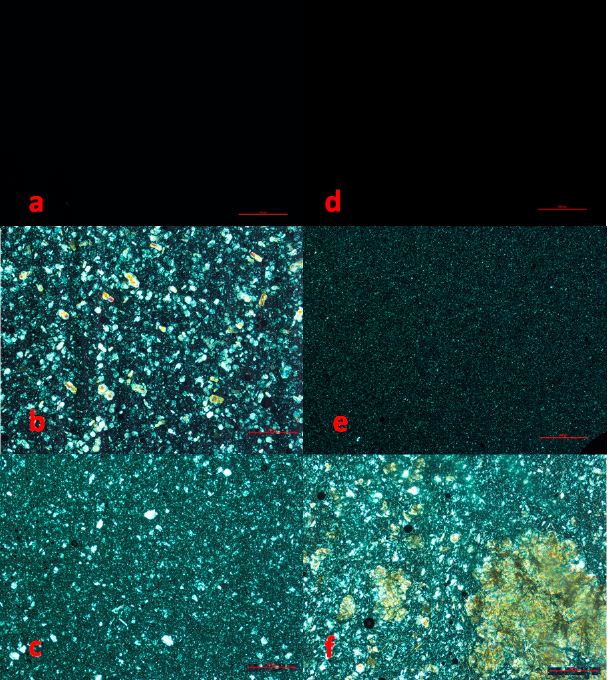
Figure 2. Microscopic images of citrus honey: liquid ( a ), creamy ( b ), and crystallized ( c ). Microscopic images of rape honey: liquid ( d ), creamy ( e ), and crystallized ( f ) at a magnification of 4×. Bars correspond to 500 μ m.